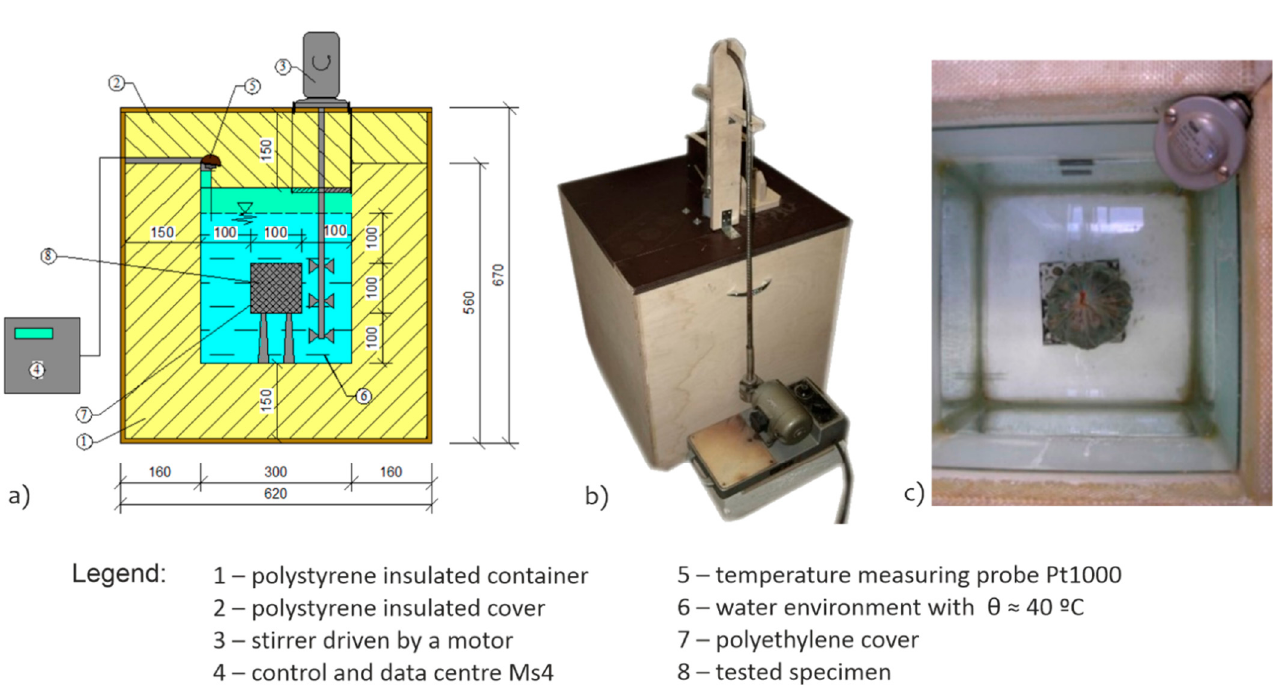
Figure 1. Calorimetry ( a ), determination of specific heat capacity of crushed aggregate ( b ), photo of the inside of the calorimetry ( c ).